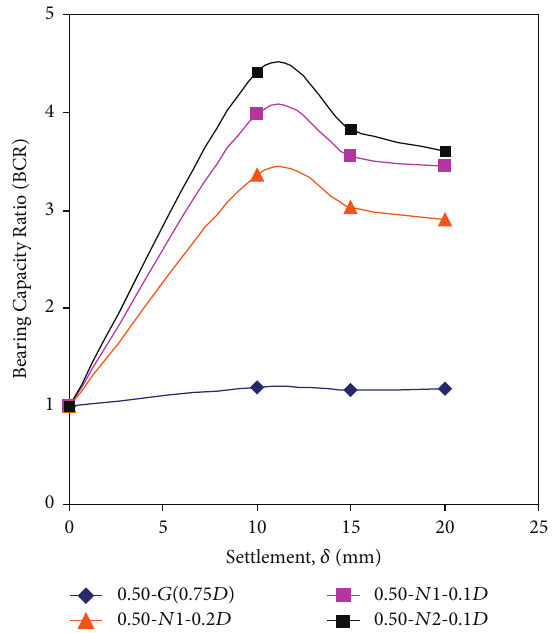
Figure 17: Bearing Capacity Ratio (BCR) for Series III ( 𝐷 = 0.75 𝑀 ),